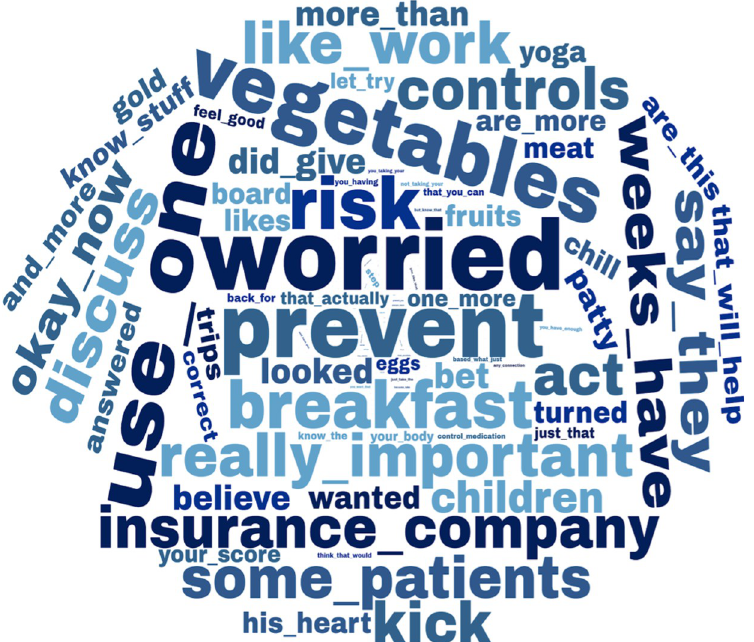
Fig 3. Words and expressions associated with poor Inhaled corticosteroids